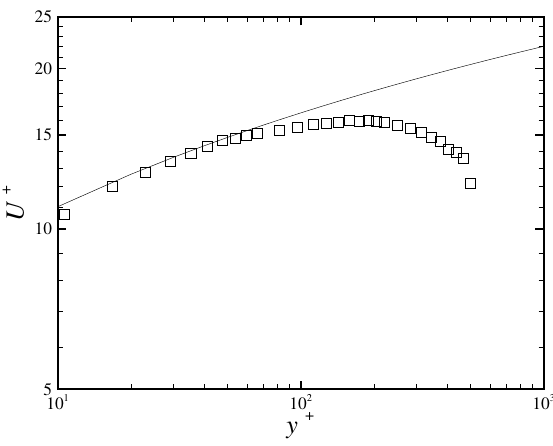
Fig. 17 Cross-streamwise profile of the normalized friction velocity at x / d = 30 ( U 0 = 12.9 m / s). means of HF sensor shows that HF sensor can detect wall shear stress precisely caused by the velocity gradient of the cross-streamwise profile of the streamwise velocity in a boundary